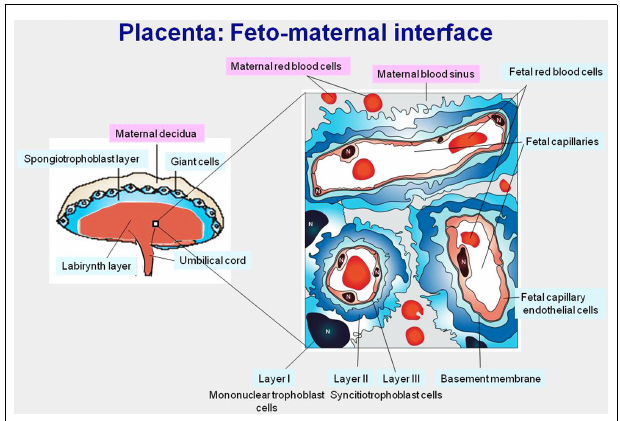
FIGURE 2 | Mouse mature placenta. Left : mouse placenta is composed of labyrinth, spongiotrophoblast, and giant cell layers. Right : magnified view of the labyrinth layer. In the labyrinth layers, fetal capillaries are surrounded by three layers of trophoblast cells and are bathed in maternal blood, functioning as a site of nutrient and gas exchange between the fetal and maternal